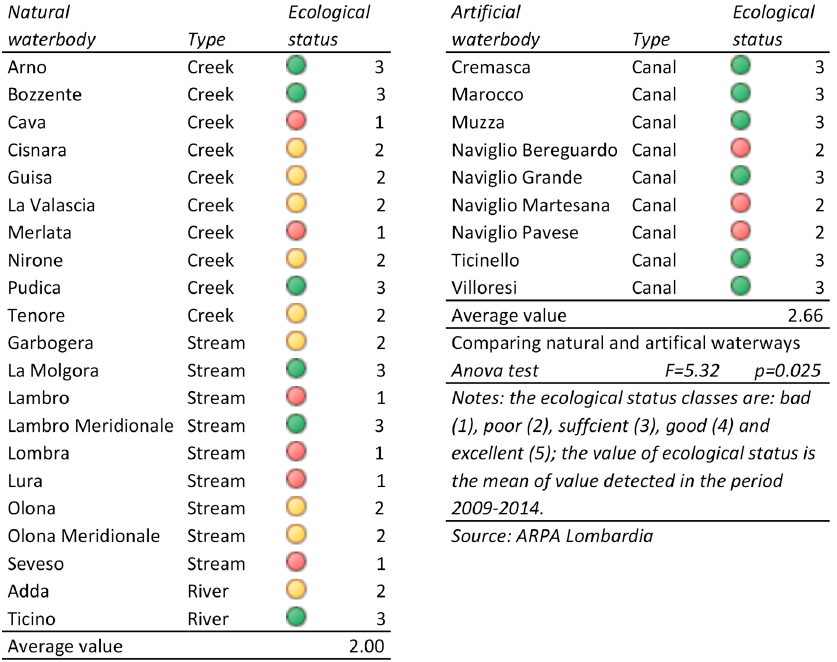
Figure 1. Natural and artificial water bodies quality.